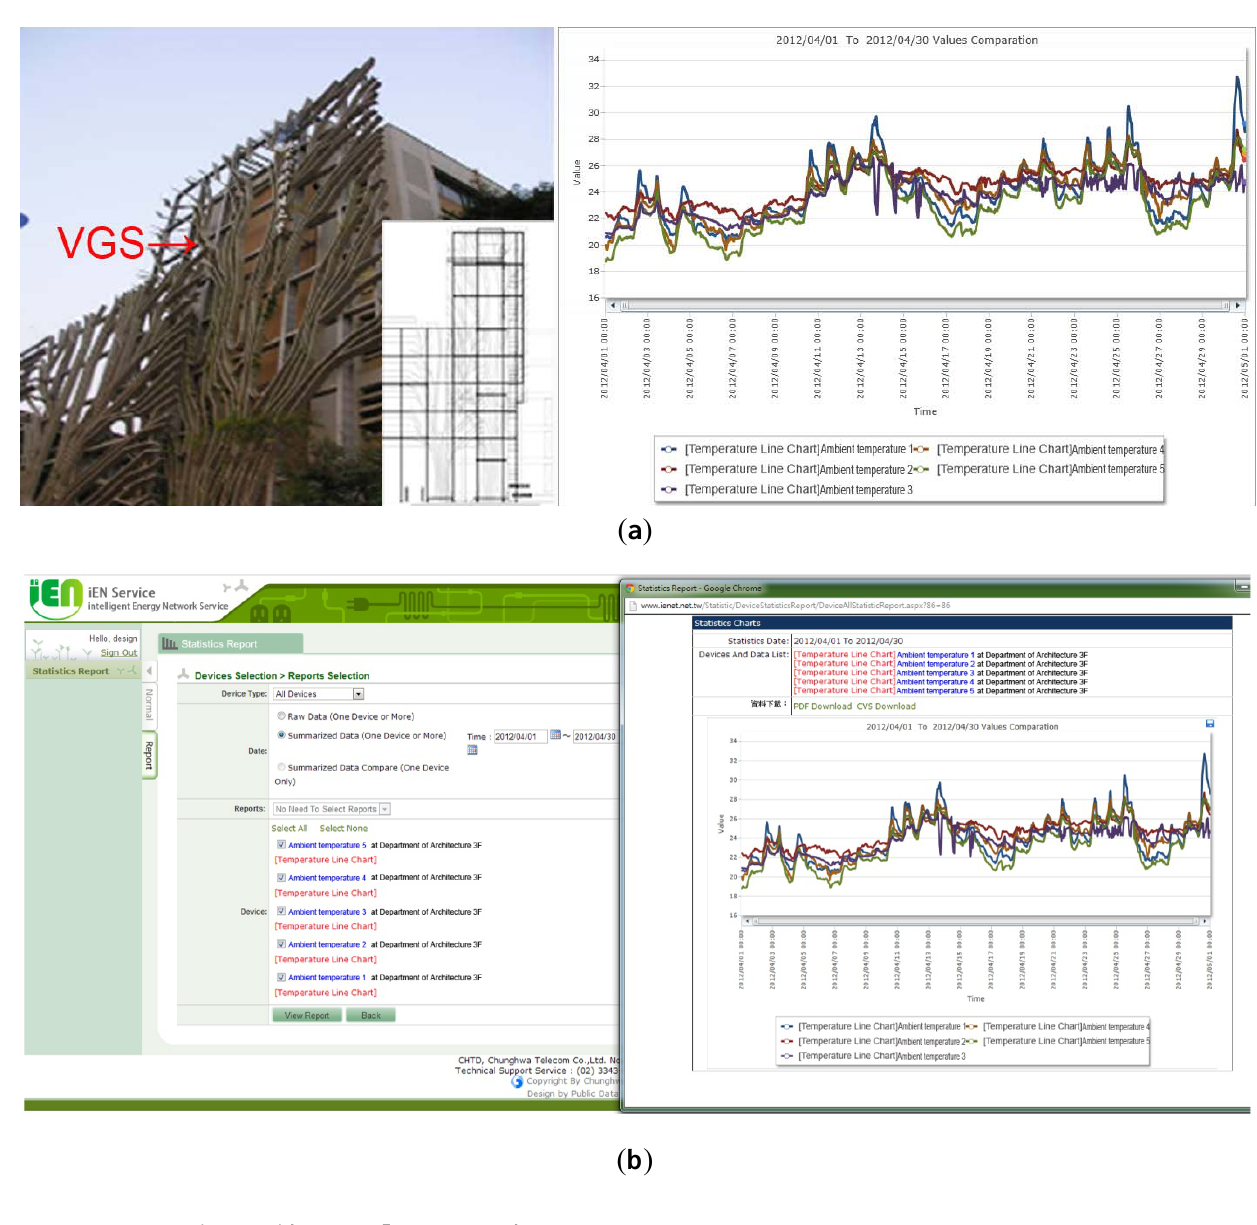
Figure 9. VGS and cloud management system (user interface of